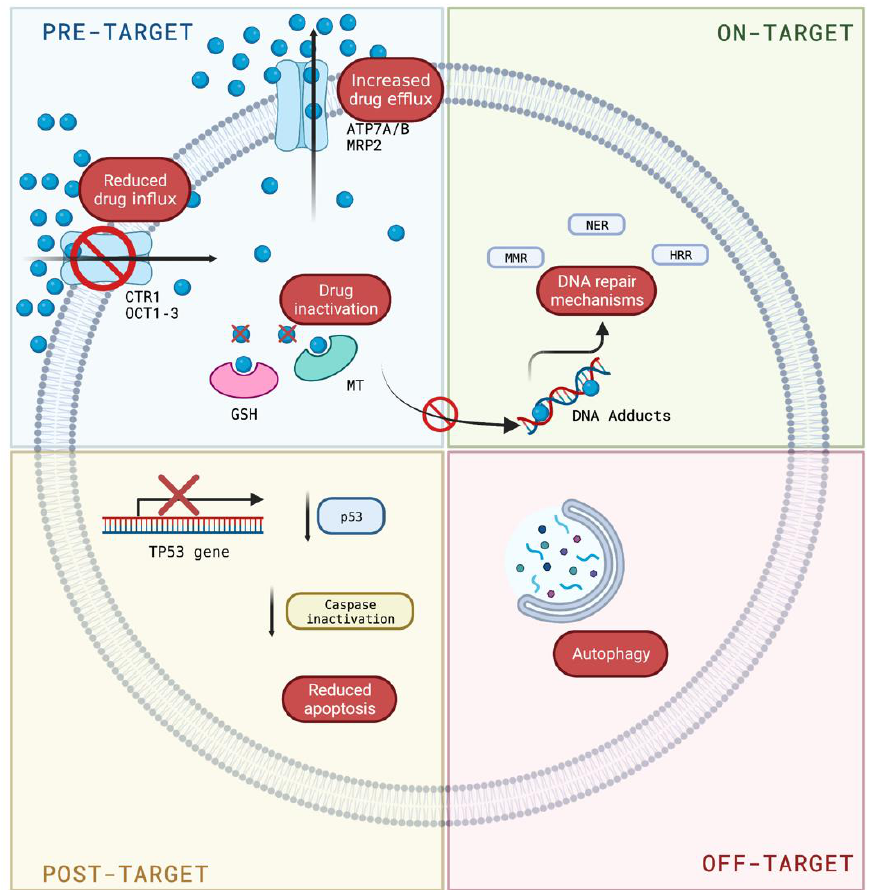
Figure 2. Mechanisms of resistance to cisplatin. Pre-target resistance related to the control of the entry or exit of cisplatin into the cell; on-target resistance implicates mechanisms involved in DNA damage; post-target resistance includes mechanisms that interfere with cell death caused by DNA adducts; and off-target resistance is related to cisplatin-induced proapoptotic events. Blue circle: cisplatin. Created with Biorender.com (https://biorender.com/, accessed on 1 August 2022).